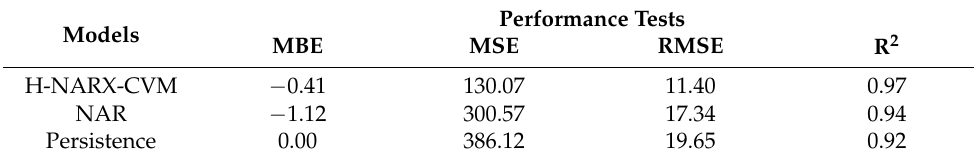
Table 11. Performance tests of the H-NARX-CVM, NAR and persistence models.